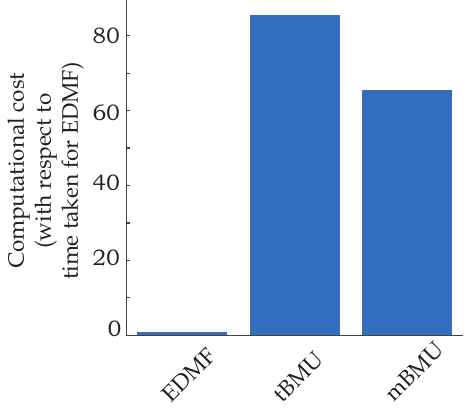
Figure 8. A change in prior distribution size requires simulation of only additional model instances to evaluate their compatibility with measurements when using EDMF.